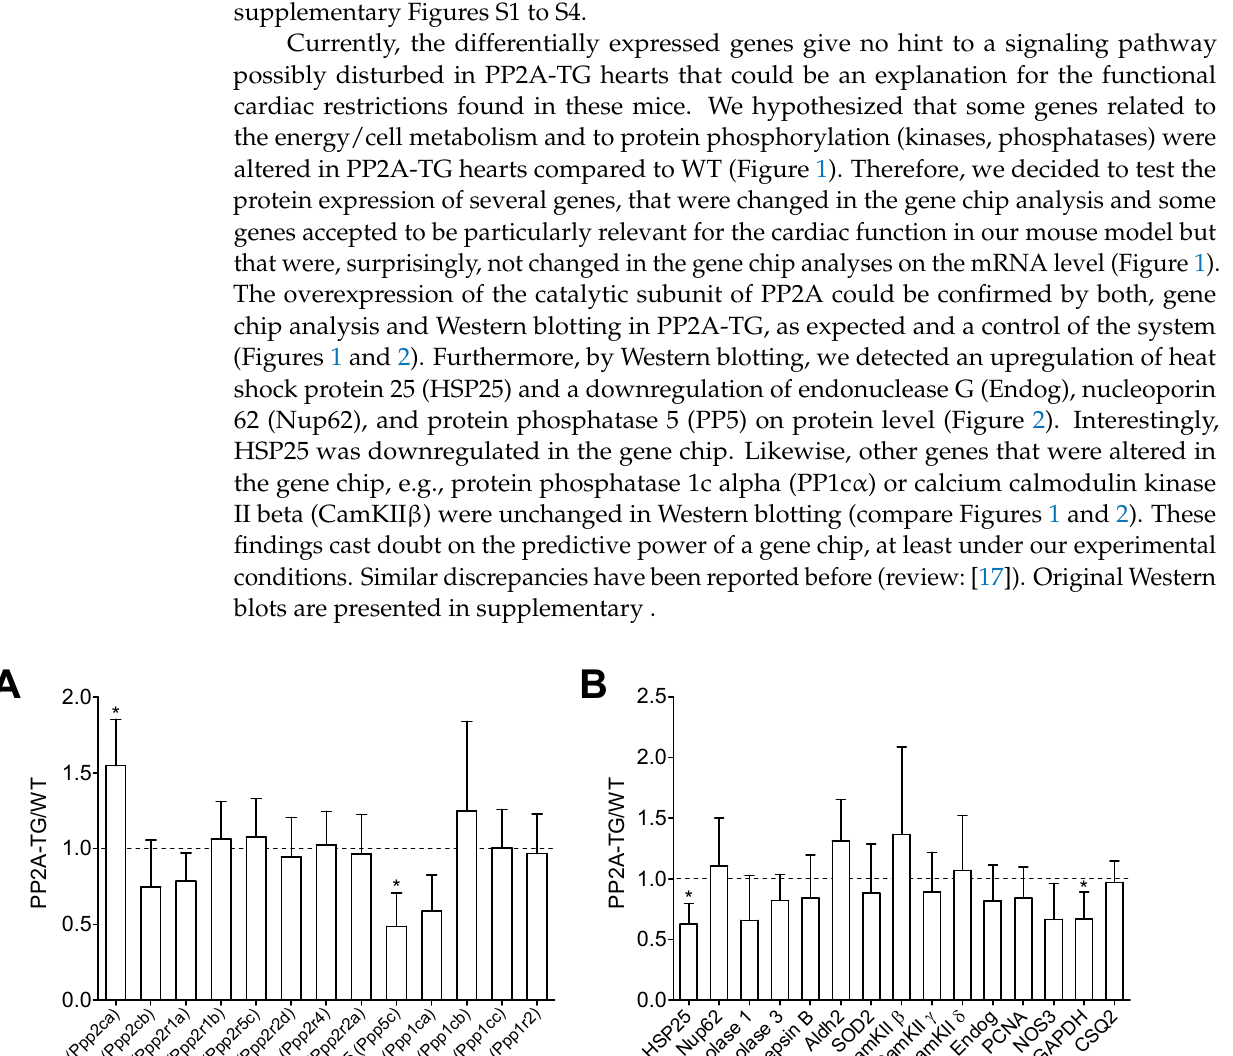
Figure 1. Differential mRNA expression. The basal cardiac gene expression profile of PP2A overexpressing (PP2A-TG) and littermate wild type (WT) mouse hearts was analyzed by a mouse genome gene chip. Data are presented as ratio of the mean PP2A-TG signal divided by the mean WT signal ± SD. More detailed data can be found in the supplementary Tables S1–S3 and supplementary Figures S1–S4. ( A ) Several subunits of different protein phosphatases are summarized. ( B ) A selection of genes with various functions is shown. The abbreviations are: aldehyde dehydrogenase 2 (Aldh2), Ca 2+ calmodulin kinase II (CamKII), cardiac calsequestrin (CSQ2), endonuclease G (Endog), glycerin aldehyde phosphate dehydrogenase (GAPDH), heat shock protein 25 (HSP25), nitric oxide synthase 3 (NOS3), nucleoporin 62kDa (Nup62), proliferating cell nuclear antigen (PCNA), superoxide dismu- tase 2 (SOD2). Three RNA samples from each genotype (n = 3) were studied. * p < 0.05 vs. WT (by comparison of individual data